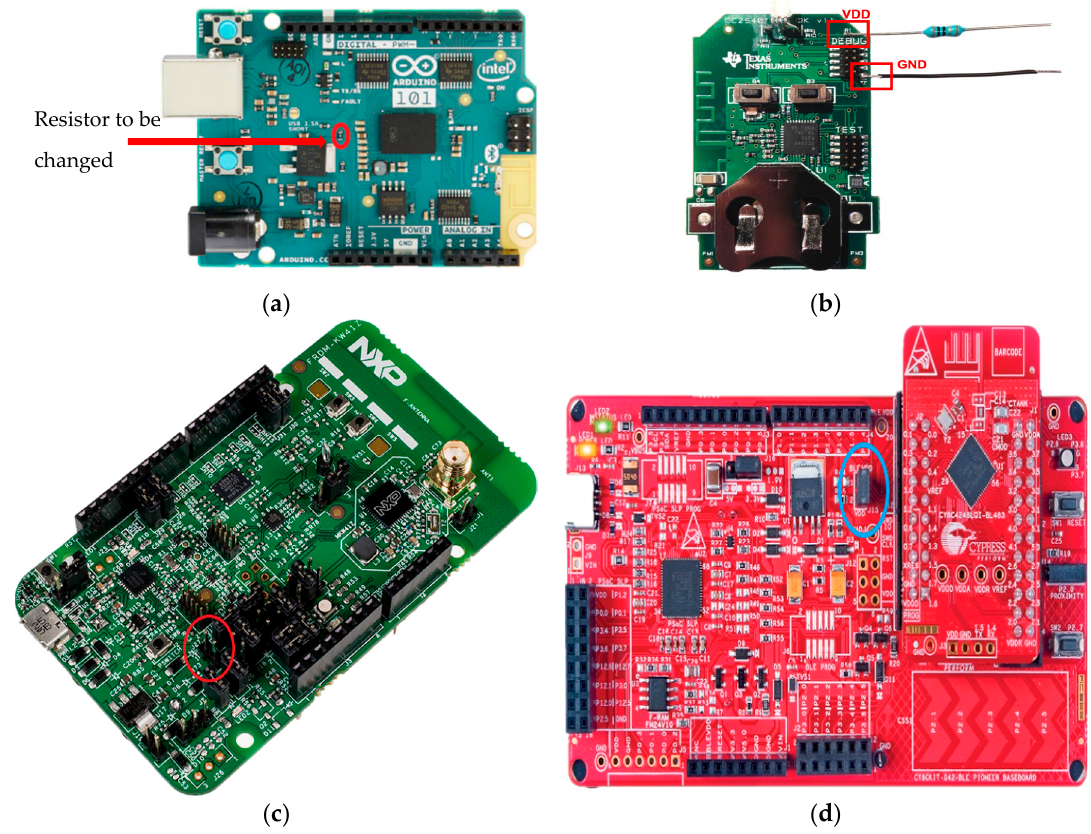
Figure 1. The four platforms used in the experiments and the required hardware modifications: ( a ) Intel A-101, red circle shows the location of the resistor to be changed; ( b ) TI CC2540; ( c ) NXP FRDM-KW41Z, red circle shows the location of the jumper where the resistor can be placed; and ( d ) Cypress CY8CKIT-042-BLE-A, where the blue circle shows the location of the jumper where the resistor can be placed.